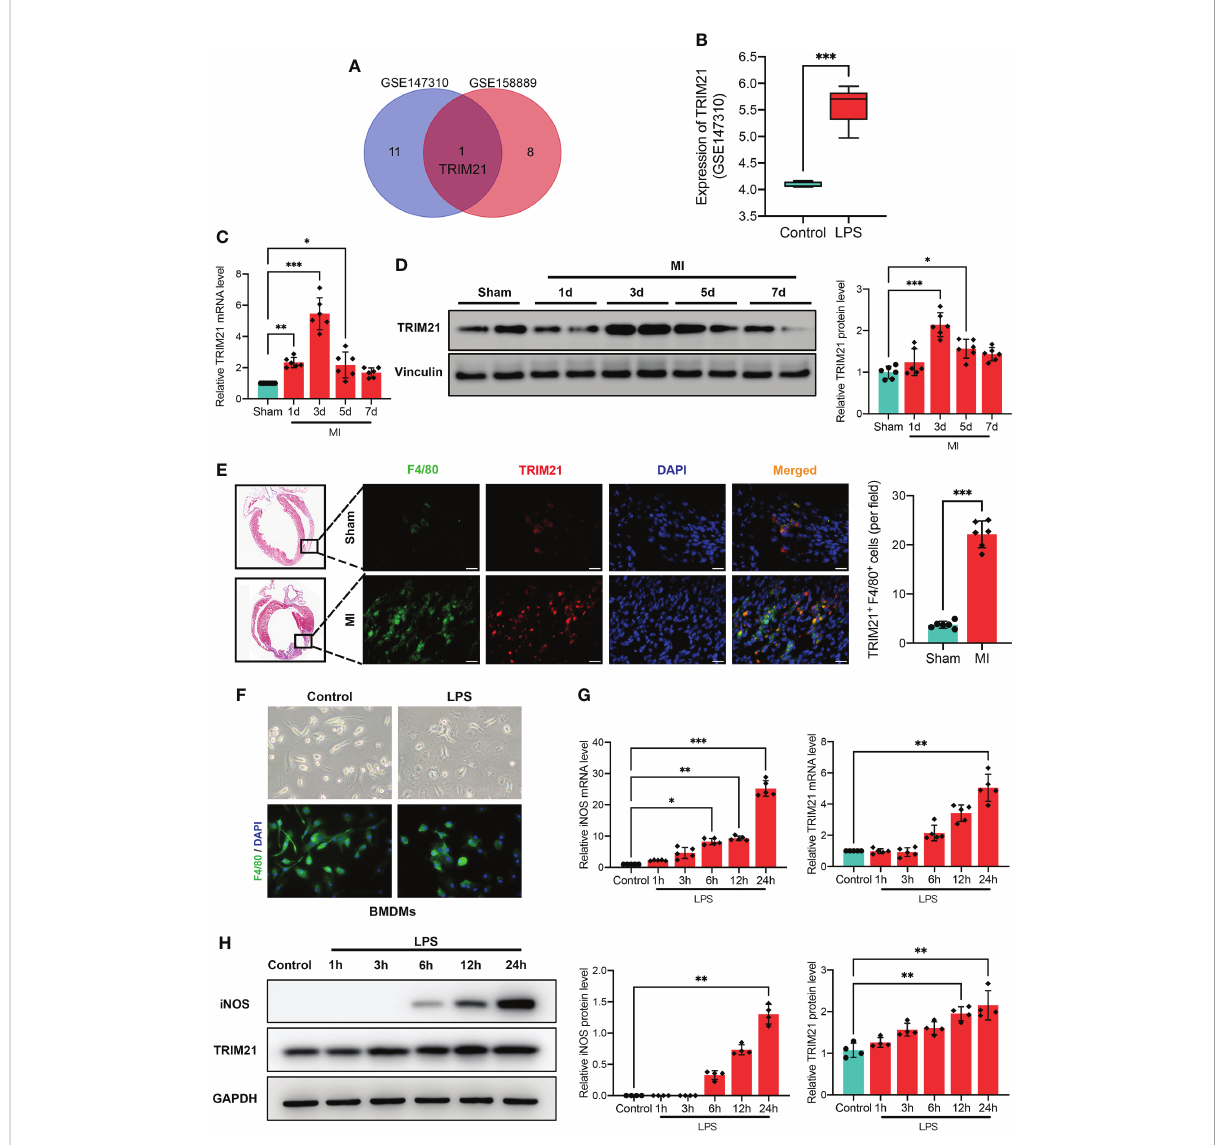
FIGURE 1 Increased TRIM21 expression after MI and in macrophages by LPS. (A) Comparison of upregulated DEGs in GSE147310 and GSE158889 microarray indicates the intersecting gene of TRIM21. (B) TRIM21 expression treated with or without LPS in GSE147310. Relative TRIM21 mRNA (C) and protein (D) levels in the infarcted areas of heart tissues following MI at day 1, 3, 5, and 7, as compared with Sham group. n = 2 mice/ group pooled from 3 independent experiments. (E) Representative Masson Trichrome staining (left) and immunostaining (right) of TRIM21 (red), F4/80 (green) and DAPI (blue) in the hearts of sham and MI groups (3 days after MI). Scale bar: 20 m m. n = 2 mice/group pooled from 3 independent experiments. (F) Representative images of BMDMs stimulated by PBS and LPS. Relative iNOS and TRIM21 mRNA (G) and protein (H) levels in BMDMs with LPS treatment for 1h, 3h, 6h, 12h, and 24h as compared with control group. Data are representative of 3 independent experiments. n = 3 sets of cells/group. *P<0.05, **P<0.01, and